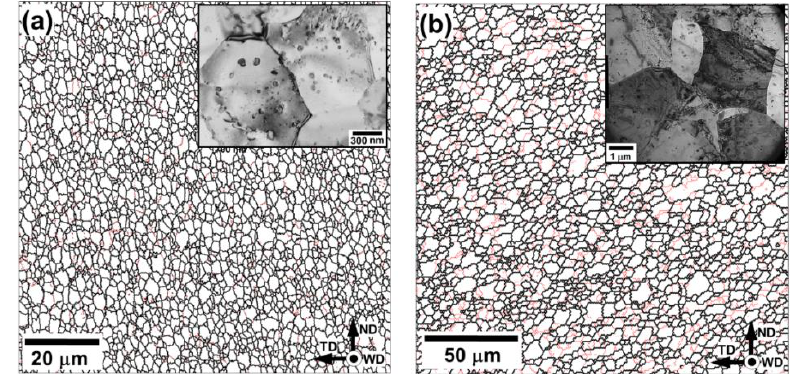
Figure 2. Typical electron backscatter diffraction (EBSD) grain-boundary maps taken from the stir zone center of friction-stir welded ( a ) Al-Mg-Sc alloy and ( b ) 6061 alloy. Transmission electron microscopy (TEM) images of the relevant microstructures are given in the top right corners of the maps. In the EBSD maps, low-angle boundaries (LABs) and high-angle boundaries (HABs) are depicted as red and black lines, respectively. In ( a ), the microstructure of the hot-rolled material condition is shown.